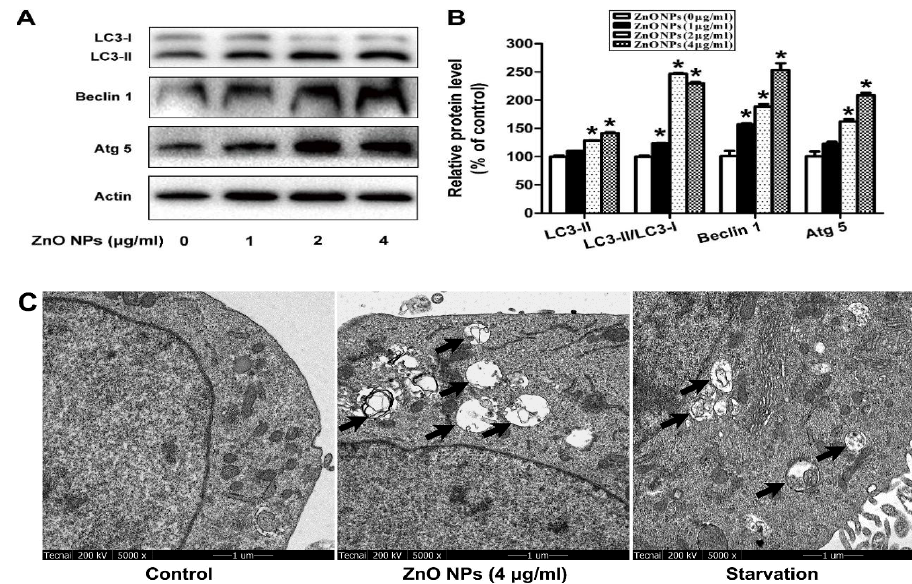
Figure 20. ZnO NPs induces autophagy of GC-1 spg cells: ( a ) Western blot analysis of protein levels of ATG5, Beclin1 and LC3 in the cells treated with 4 μg/mL ZnO NPs for 24 h. Actin is employed as an internal control. ( b ) Densitometry quantification of relative protein levels. ( c ) TEM images showing autophagic vacuoles of untreated cells (control), and cells treated with 4 μg/mL ZnO NPs for 24 h. Starvation-treated cells act as a positive control. Autophagic vacuoles are indicated by the arrows. * p < 0.05 compared to control. Reproduced from [49] under the Creative Commons Attribution license.